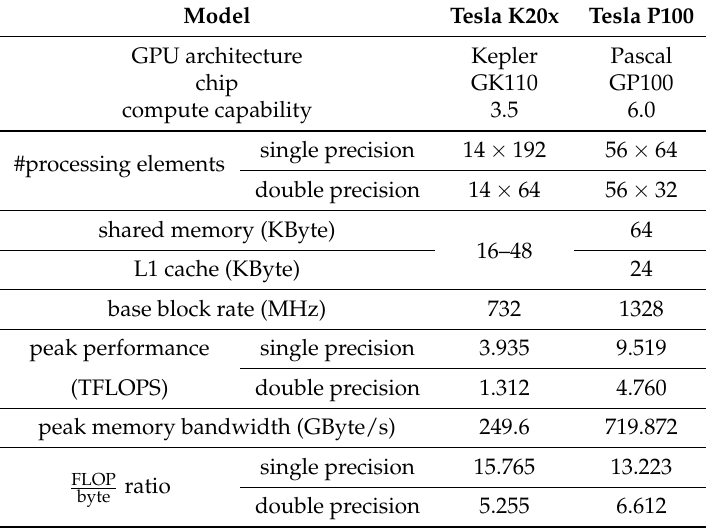
Table 2. Properties of the GPUs utilized to benchmark performance throughout this work. All GPUs are NVIDIA